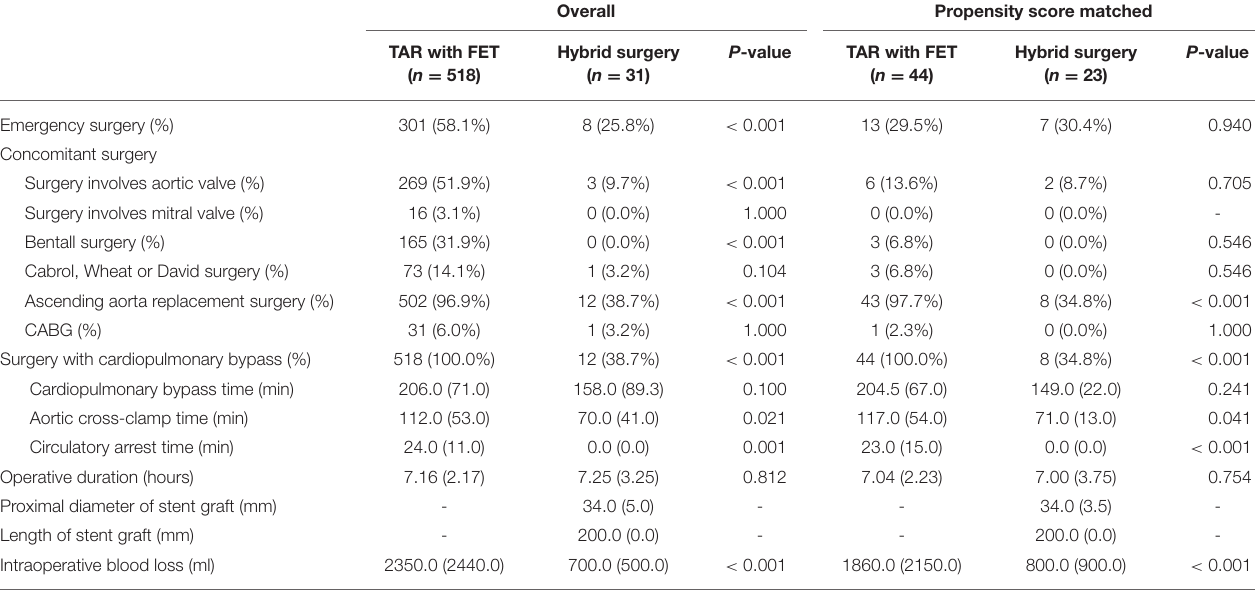
TABLE 2 | Intraoperative